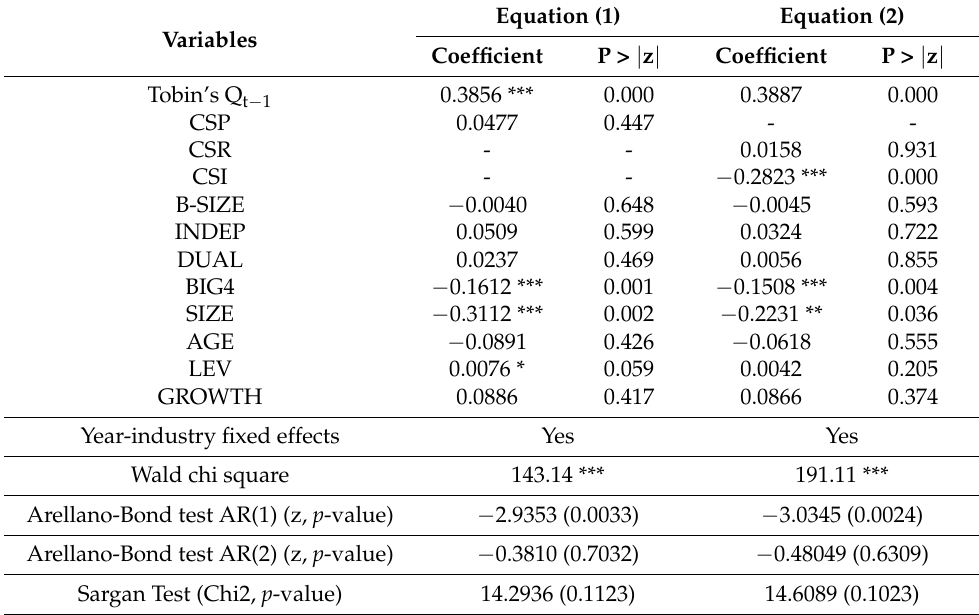
Table 4. System GMM